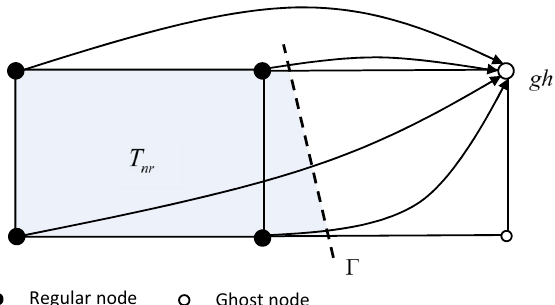
Fig. 6 Illustration of cut element stabilisation, the degrees of freedom at gh are coupled to those associated with the nearest element interior to the domain, T nr , as indicated by the